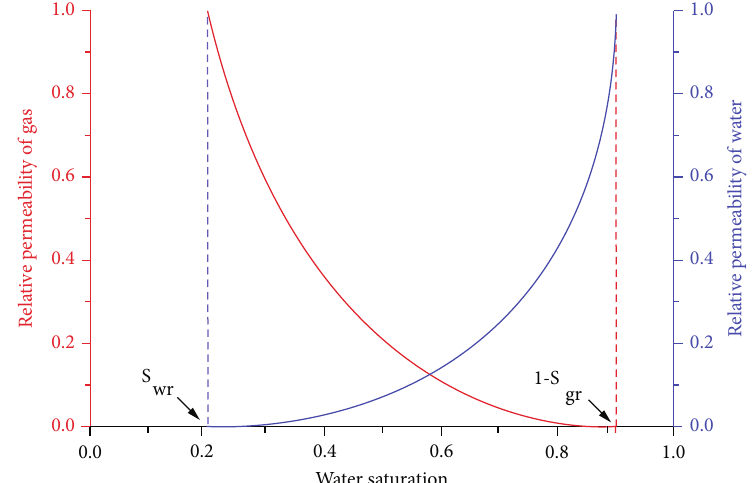
Figure 3: Relative permeability curves for two-phase fl ow.